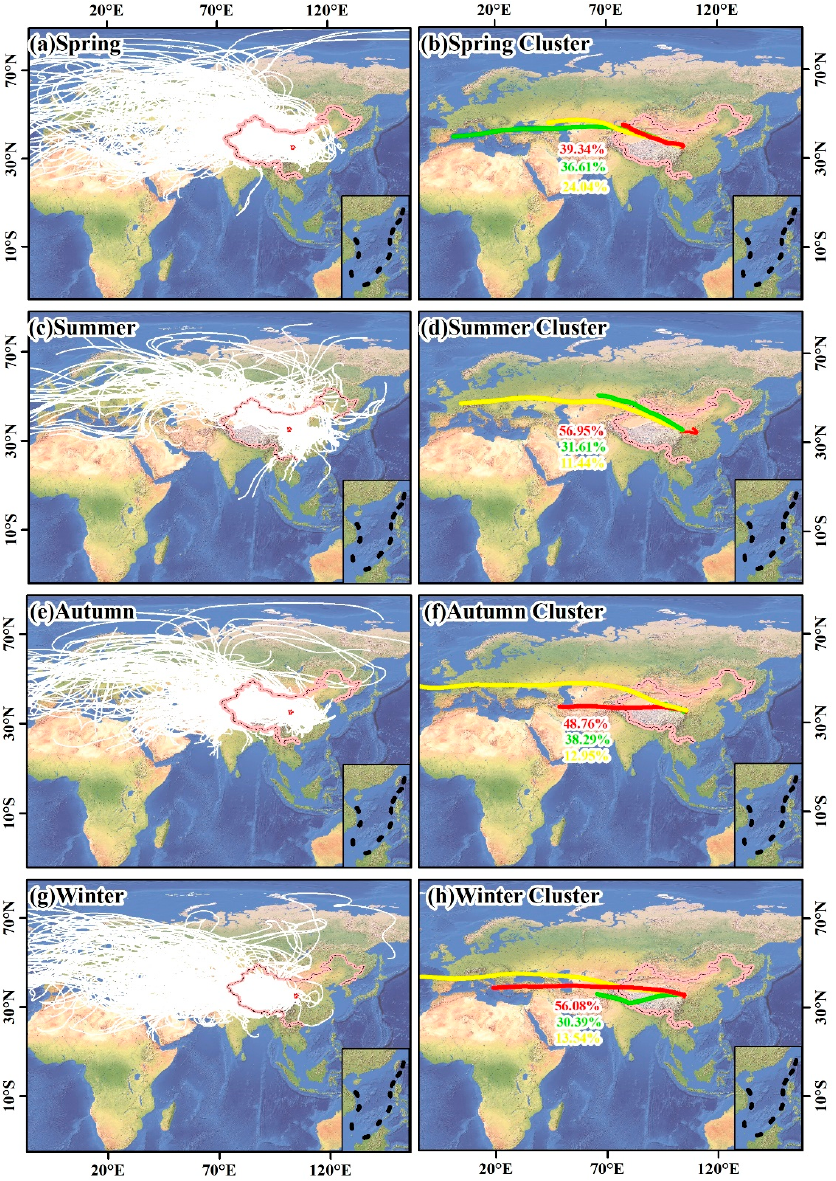
Figure 3. Back trajectories simulated by the HYSPLIT model for all sampling stations of Dingxi in spring ( a ), summer ( c ), autumn ( e ), and winter (g). ( b , d , f , h ) Map showing the three trajectories clustered according to the direction of the backward trajectory of each season. The white lines are the daily precipitation events with vapor trajectories during the preceding five days (240 h) at 1500 m agl (above the ground level). The red, green, and yellow lines represent the trajectories that account for the higher, the middle, and the least after clustering, respectively.